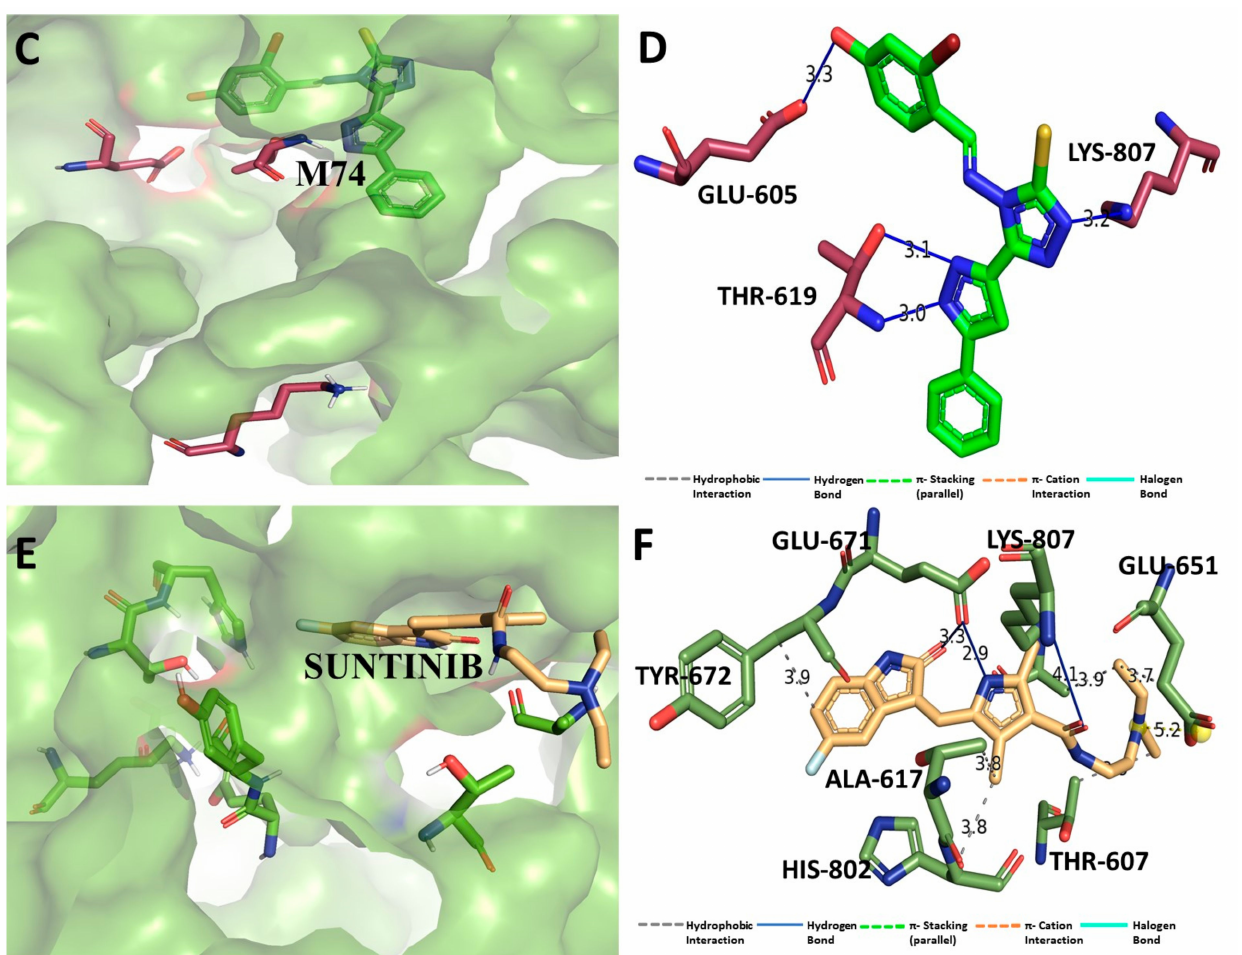
Figure 10. ( A ) Molecular docking-generated binding orientations of standard compound (sunitinib) and the proposed pyrazole-based inhibitor compound M74 in complex with c-KIT (6XVB) protein; ( B ) close-up binding interaction view exhibiting similar binding pattern of all the compounds at the active site cavity of c-KIT (6XVB) protein; ( C ) binding mode of pyrazole compound M74 in the active site cavity of c-KIT (6XVB) displayed in surface view; ( D ) molecular binding interaction and orientation of compound M74 with c-KIT (6XVB) protein; ( E ) binding mode of standard compound (sunitinib) in the active site cavity of c-KIT (6XVB) displayed in surface view; ( F ) molecular binding interaction and orientation of sunitinib with c-KIT (6XVB)